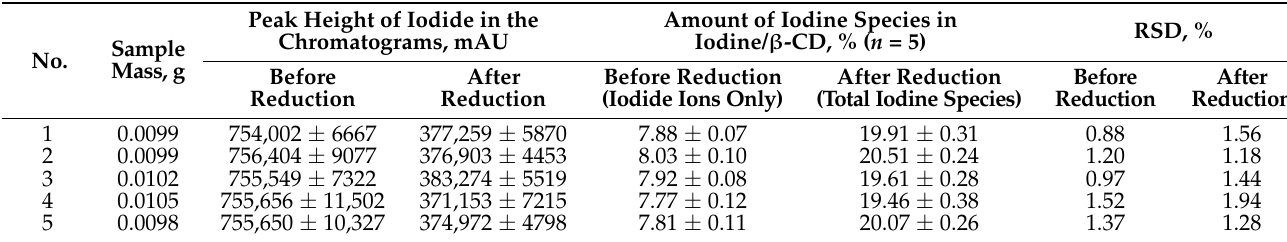
Table 1. Results of quantitation analysis.